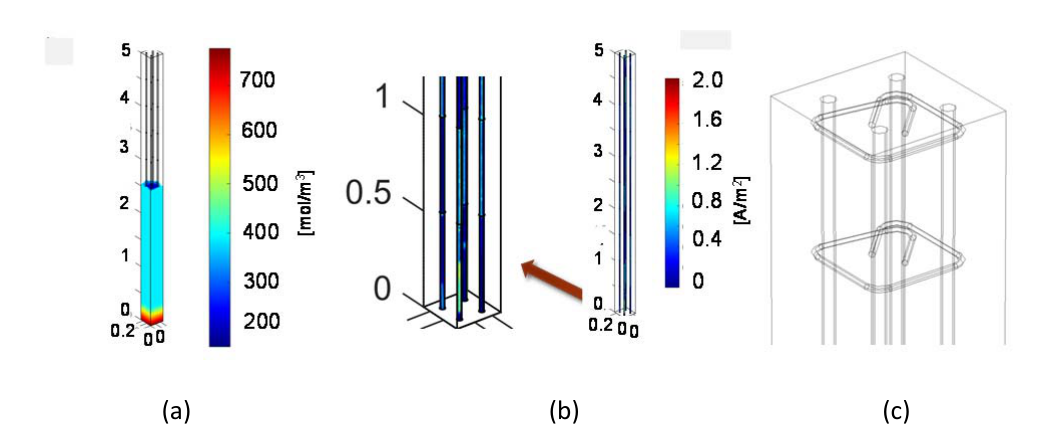
Figure 12 . 3D prediction for an un ‐ cracked beam of (a) free chloride concentration at the reinforcement surface, (b) absolute corrosion current density, and (c) rebar cage